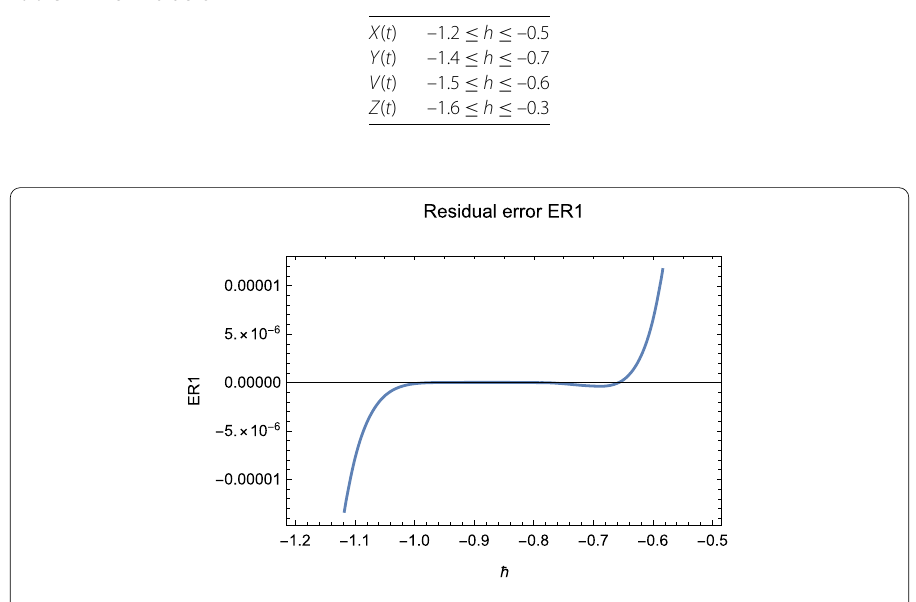
Table 2 The h value is